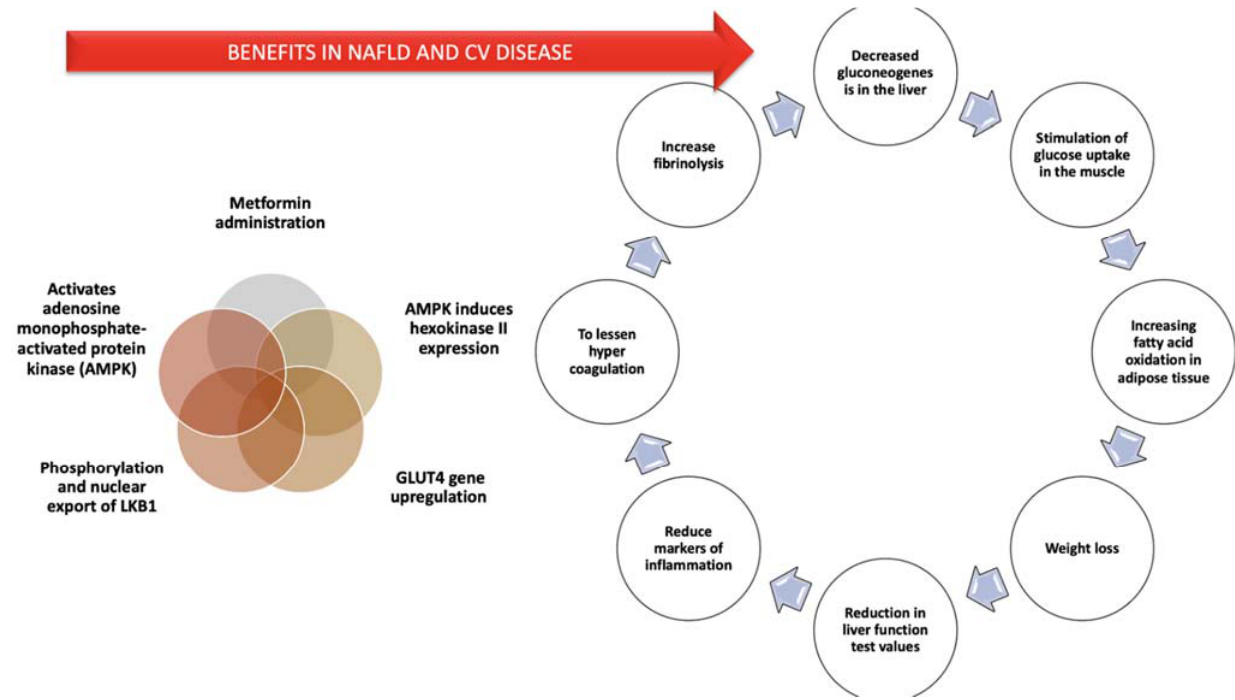
Figure 2. Benefits of metformin administration. Legend: AMPK: adenosine monophosphate ‐ activated protein kinase; LKB1: liver kinase B1; GLUT4: Glucose transporter type 4.